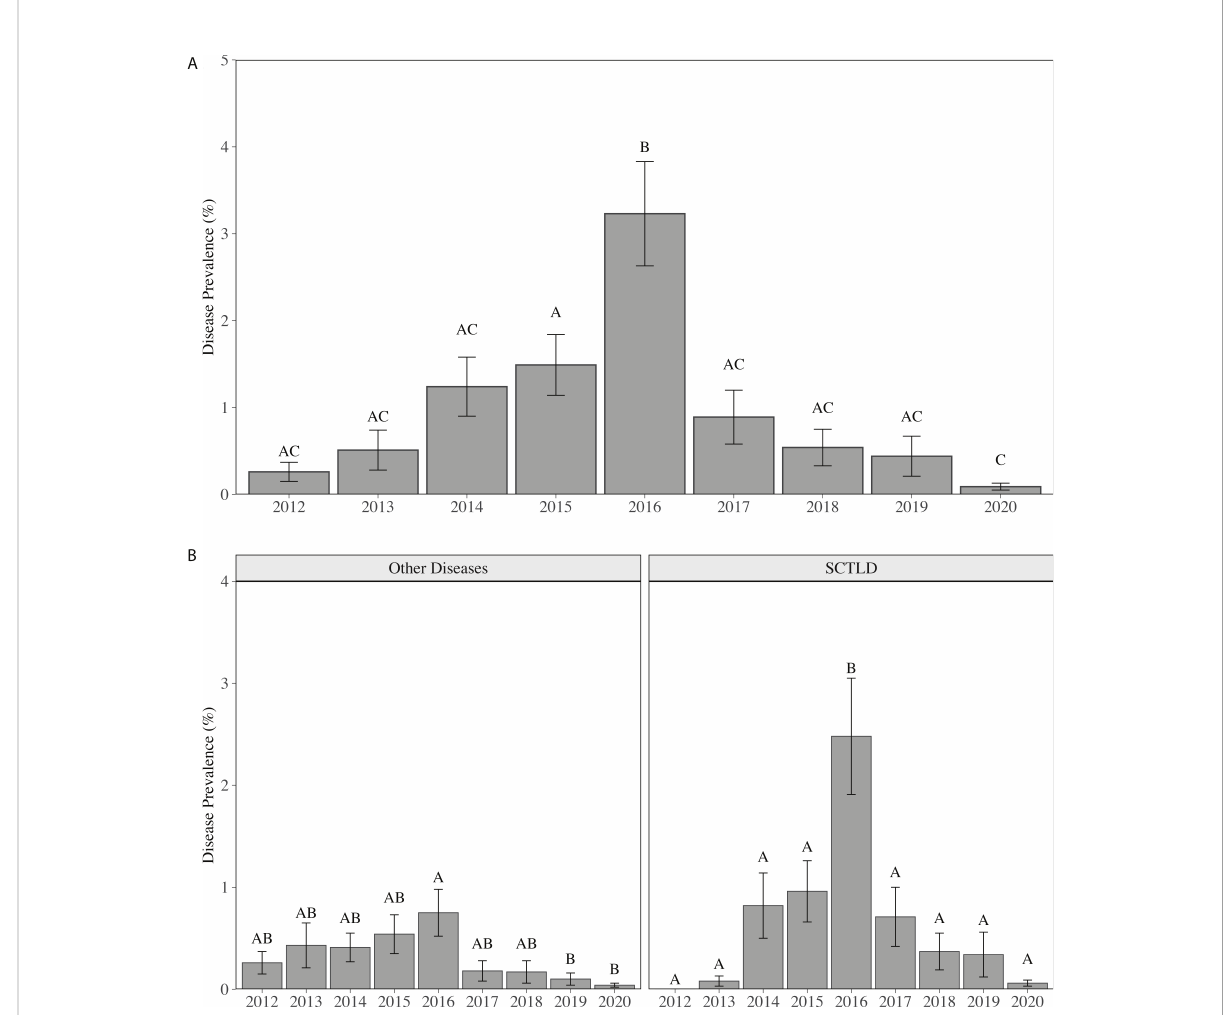
FIGURE 1 Mean (± SE) annual coral disease prevalence for (A) all diseases combined, (B) other diseases (including black band disease, yellow band disease, white band disease ( Acroporids only ), and dark spot disease) and disease visually consistent with SCTLD. Different letters above the bars indicate signi fi cant differences in disease prevalence between years (p < 0.05,